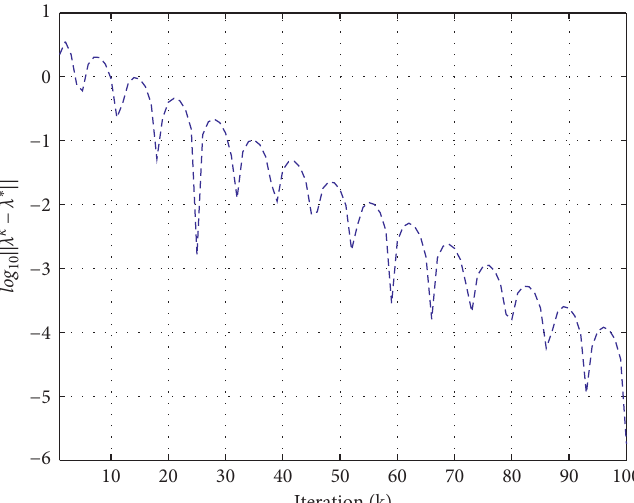
Figure 11: Convergence of the dual variable iterates λ k in ADMM. The figure shows the log values of ‖ λ k − λ ∗ ‖ with iteration number. A better convergence up to 10 − 6 tolerance is achieved within 100 iterations.